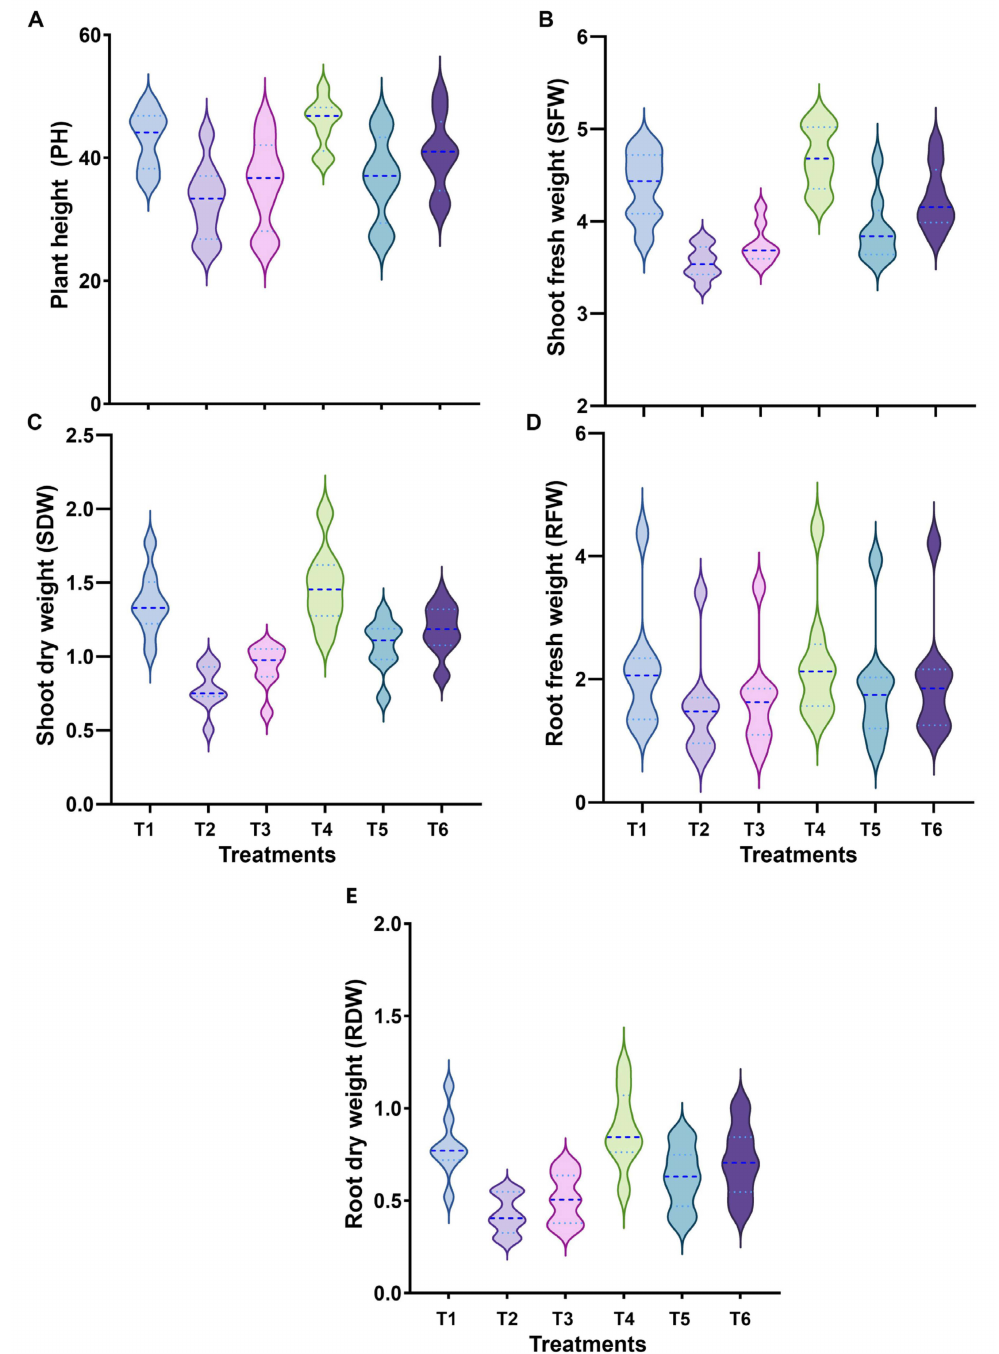
Figure 2. Comparison of morphological traits by violin plots: ( A ) plant height (PH), ( B ) shoot fresh weight (SFW), ( C ) shoot dry weight (SDW), ( D ) root fresh weight RFW), and ( E ) root dry weight (RDW) among eight wheat genotypes under drought, and heat stress and their response to SeNPs application. Treatments: T1, control (regular irrigation, 100% Field Capacity (FC)) at (day/night) temperature of 23/17 ± 3 ◦ C; T2, drought stress (60% FC); T3, heat stress (38 ◦ C); T4, 10 mg · L − 1 of SeNPs; T5, drought stress (60% FC) + 10 mg · L − 1 of SeNPs; and T6, heat stress (38 ◦ C) + 10 mg · L − 1 of